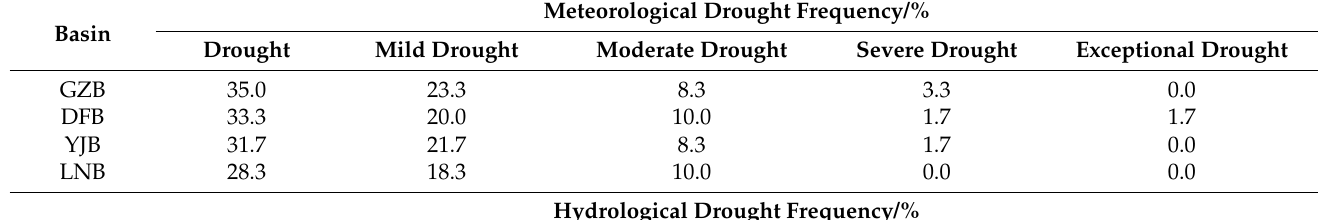
Table 2. Interannual drought frequency in the YLB from 1960 to 2019.